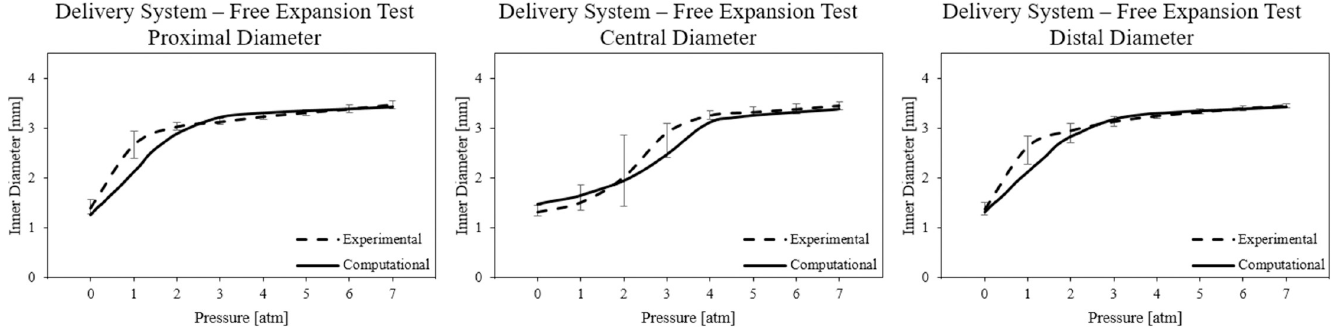
Fig 7. Pressure-diameter curves obtained experimentally and computationally from the free expansion of the delivery system. Error bars indicate the maximum and minimum experimental value of diameter reached with respect to the mean value at the corresponding pressure.